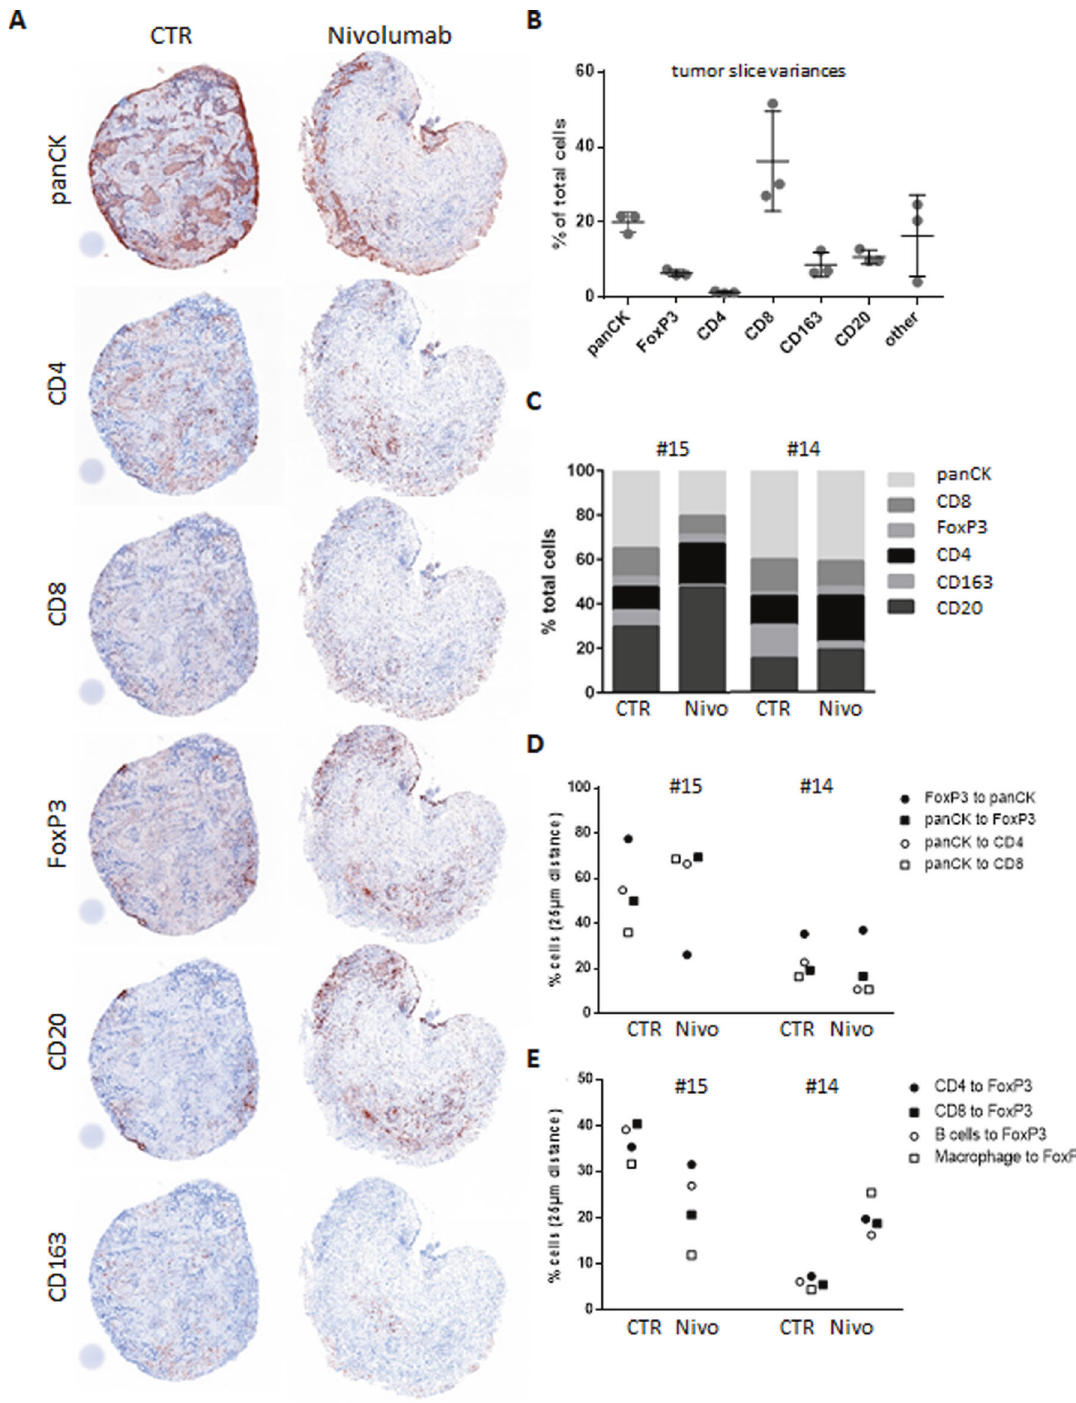
Fig. 5 Multispectral imaging (MSI) analysis discriminates responding tissues. Tissue was stained with Ab against CD3, CD8, CD163, CD20, Foxp3, and panCK and was evaluated by MSI. A Representative staining of the single antibody upon conversion of the multispectral image into a pathological DAB-like view. B Three tissue pieces from the same patient were stained and evaluated for the percentages of the different cell populations. C The frequency of the different immune populations as well as tumor cells within the tissue are shown for the responder and nonresponder samples treated or not with nivolumab for 5 days. D, E The spatial organization of tumor cells and immune cells was evaluated by calculating the frequency of cells having a cell from another phenotype within a 25 μ m radius. Data are shown for relationship involving panCK + cells ( D ) or FoxP3 + cells ( E